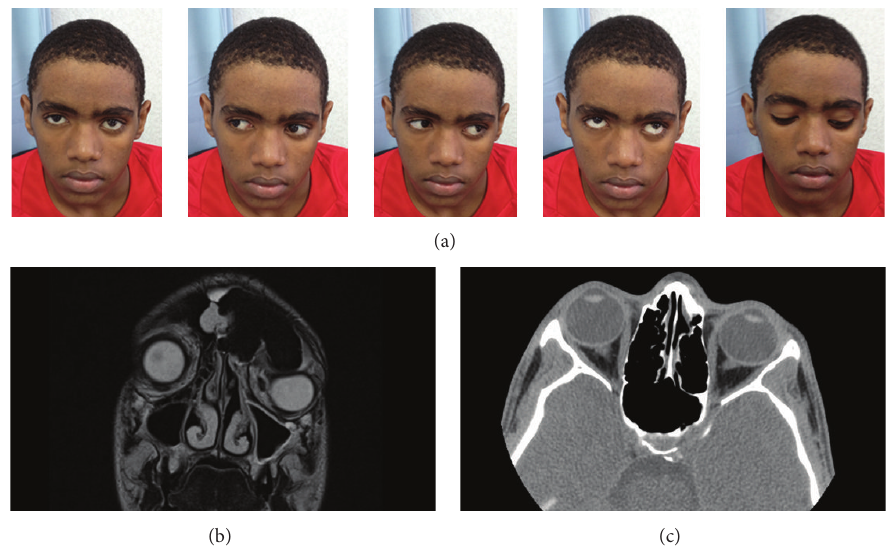
Figure 3: Postoperative patient photo demonstrating the resolution of proptosis and fulleye movements (a). Preoperative coronal MRI orbit showing the degree of compression on the orbit (b). Postoperative CT orbit showing the resolution of proptosis